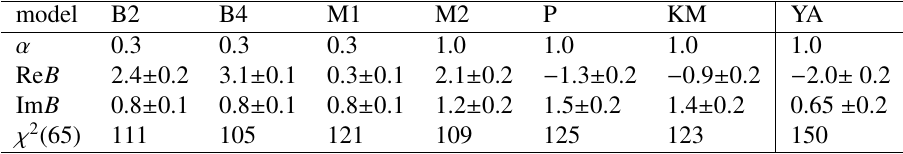
Table 2. Fits to 65 kaonic atoms data points when single-nucleon amplitudes are supplemented by a α term with fixed α compatible with its best-fit value. B in units of B ( ρ/ρ 0 )